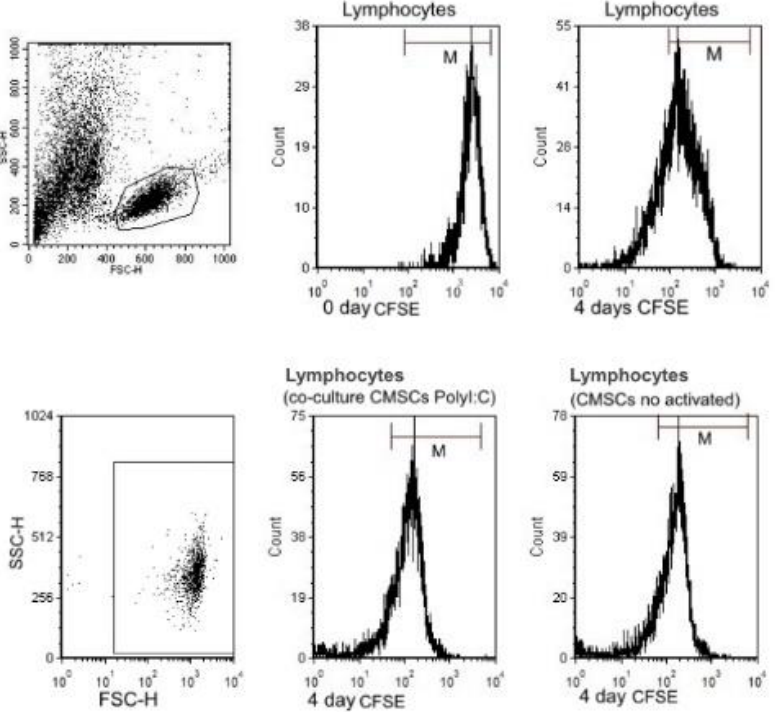
Figure 6. Flow cytometry analysis of carboxylflurescenin succinidyl ester (CFSE) fluorescence intensity of three groups of co-cultured PHA lymphocytes CFSE and CMSCs. Inhibitory effect of CMSCs after 4 days of co-culture. Representative flow cytometry analysis for lymphocytes. A suppressive effect on lymphocyte proliferation was observed after 4 days of co-culture of the following groups of cells. CMSCs were able inhibit the proliferation of activated lymphocyte independently of Poly (I:C) activation. Statistically significant differences were detected between experimental groups lymphocytes (LY), groups: LY/CMSCs Poly (I:C) and LY/CMSCs against the group of lymphocytes cultured alone. Post hoc analysis confirmed the statistical differences in